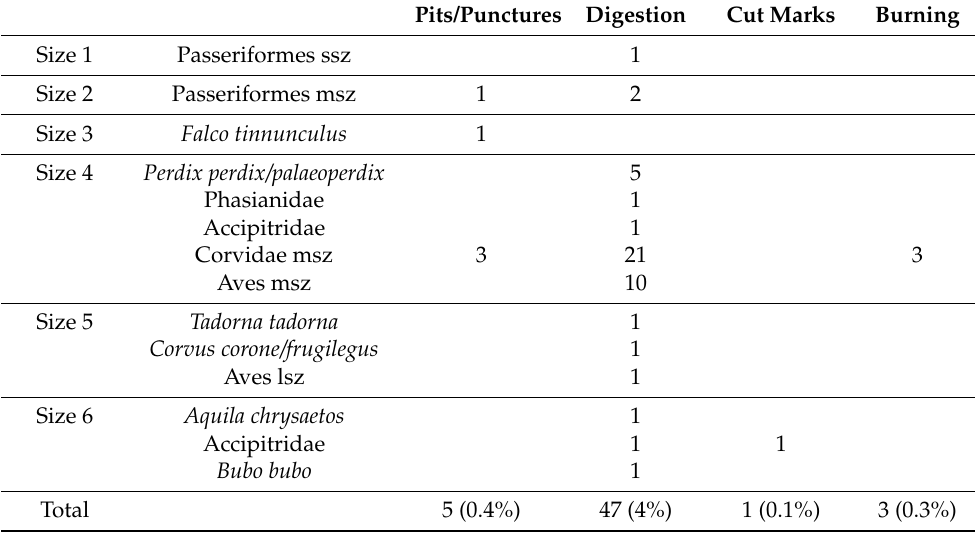
Table 2. Predatory-induced damage on bones at layer VIII of Grotte Vaufrey and its final percentage of